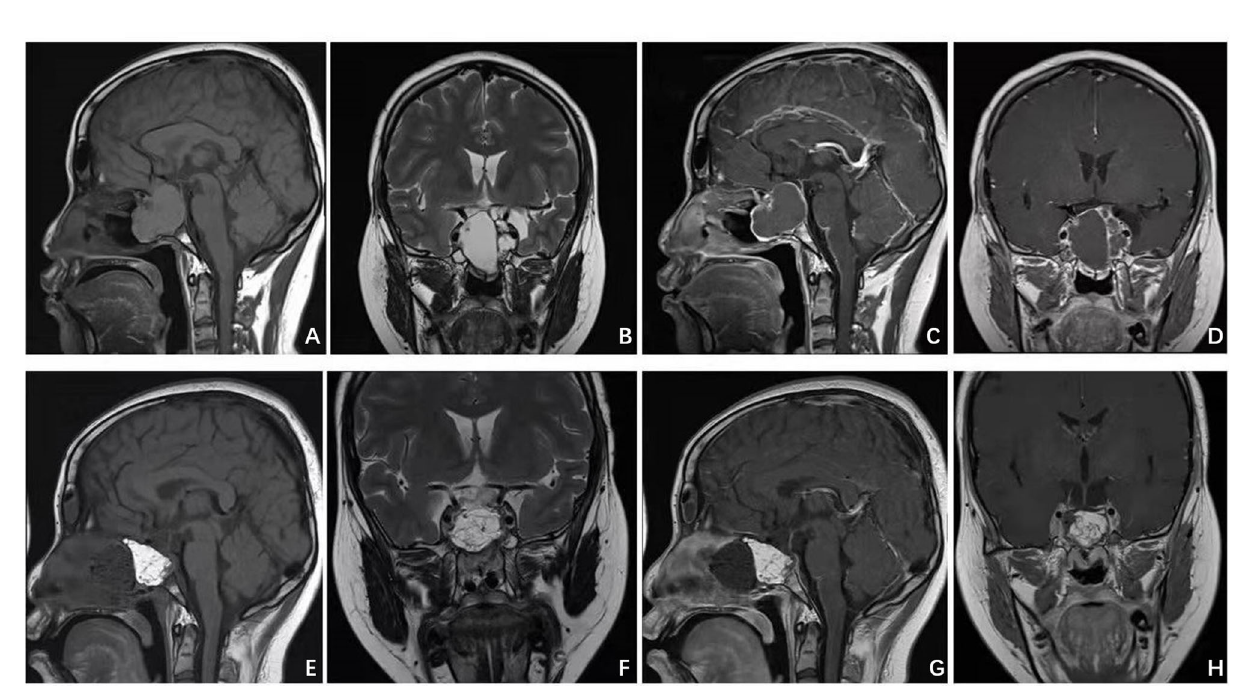
FIGURE 1 | Patient presented with visual de fi cit, pituitary and elevated intracranial pressure syndromes. Preoperative MRI (A – D) illustrated a giant intra-suprasellar craniopharyngioma. Postoperative MRI (E – H) con fi rmed gross total